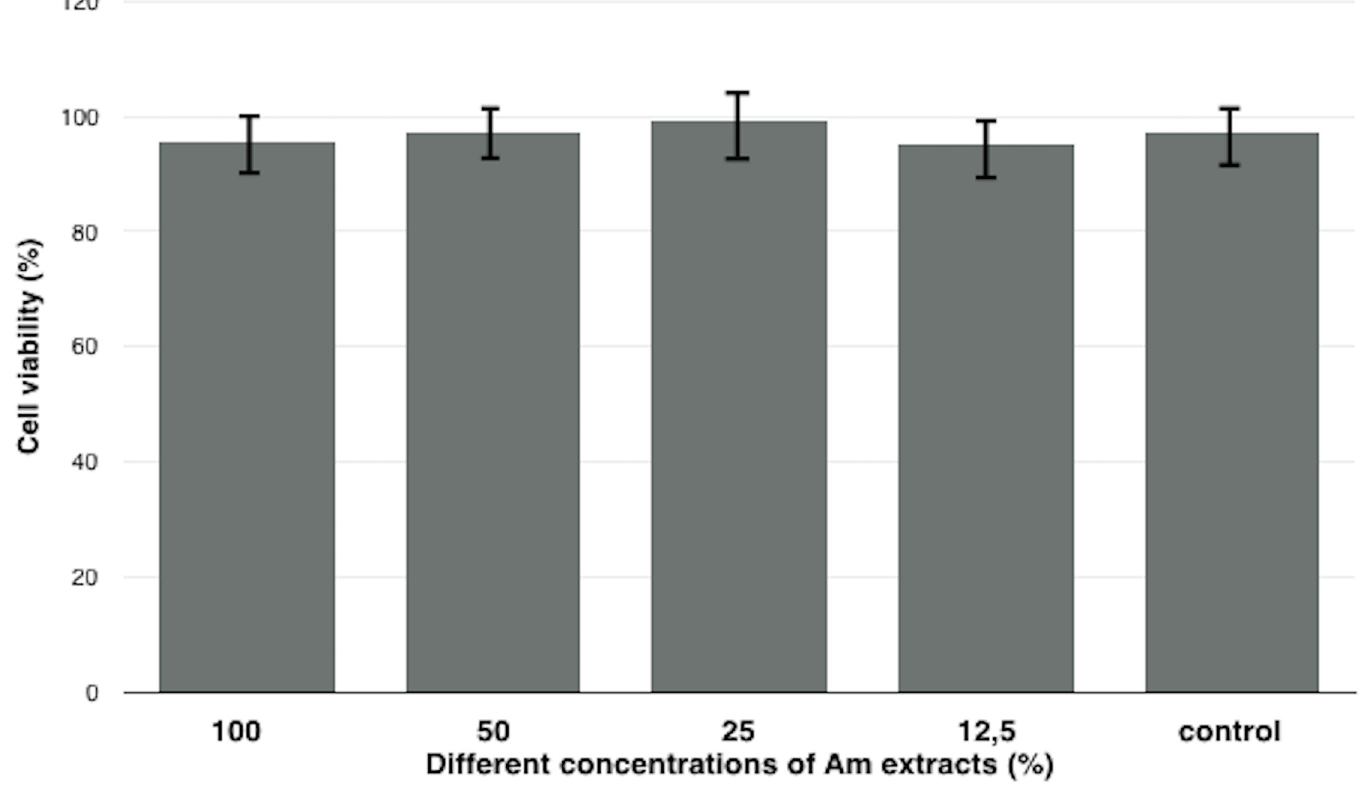
Fig 3. Amniotic membrane extract cytotoxicity measurement using the MTT assay. Each result was presented as an average from 5 independent experiment with SD bars. No statistically significant difference in cell viability was observed between AME treated and control cells (p > 0.05) after 24 hours.